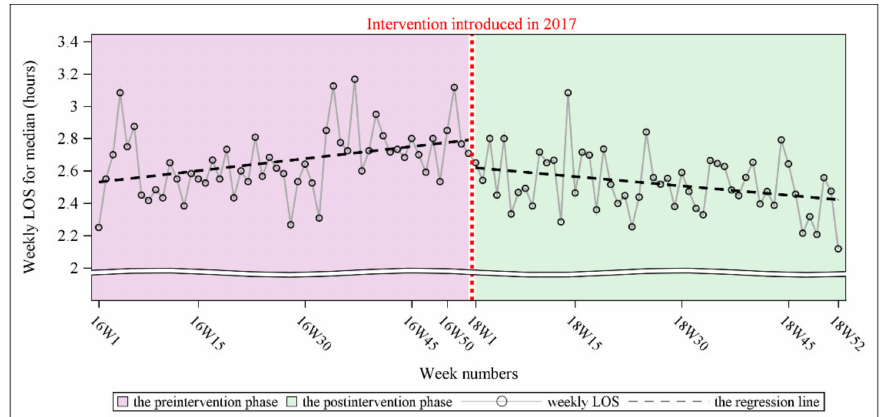
Figure 4. The comparison of weekly LOS for ED nonadmitted patient visits between the preinterven- tion phase and the postintervention